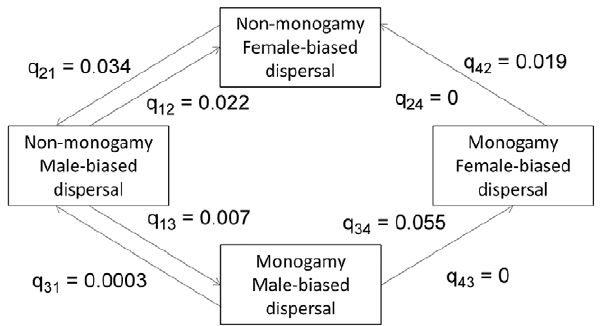
Figure 4. Path diagram showing evolutionary transition rates among four character states (Lawson Handley and Perrin’s dataset). Transitions from the ancestral state of non-monogamy and MBD to the derived state of monogamy and FBD for mammals using Lawson Handley and Perrin’s dataset are shown. Arrow thickness is proportional to the magnitude of the transition rate.